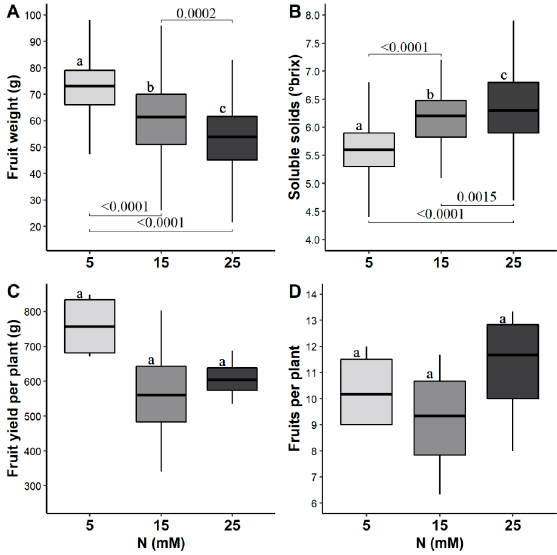
Figure 1. Fruit yield and quality from tomato plants fertigated with solutions of 5, 15 or 25 mM nitrogen (N) concentration. ( A ) Fruit weight (g); ( B ) Soluble solids (°brix) of fruit pulp; ( C ) Fruit yield per plant (g); and ( D ) Number of fruits per plant. Different letters represent a significant difference ( p < 0.05). Numbers above the brackets represent p -values for contrasts between treatments.